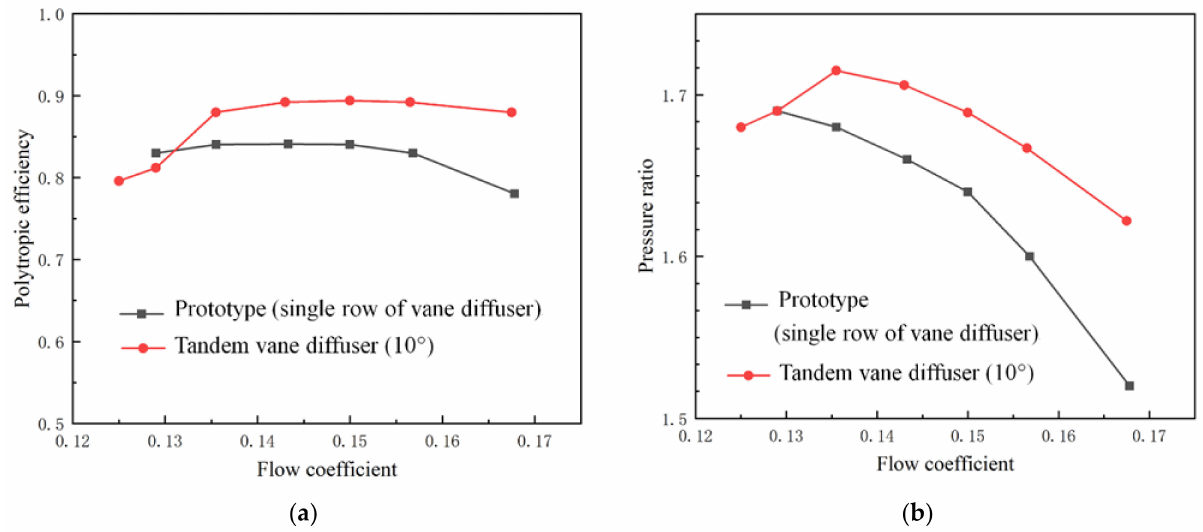
Figure 20. Comparison of the performance of centrifugal compressor stages, between the prototype with single row of vane diffuser and the stage with newly designed tandem vane diffuser of the 10 ◦ model. ( a ) Polytropic efficiency and ( b ) Total pressure